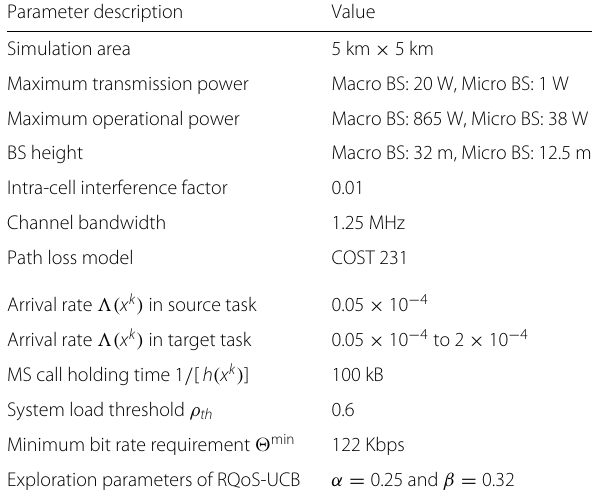
Table 2 Simulation parameters